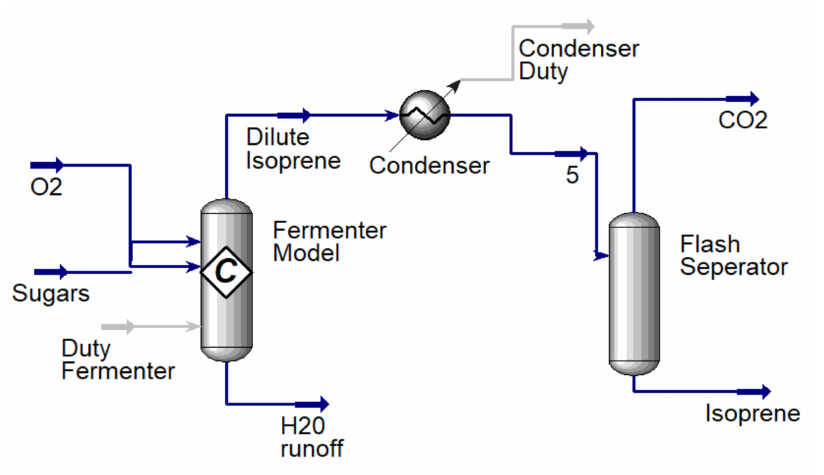
Figure 2. UniSim model of fermenter, condenser and flash separator.